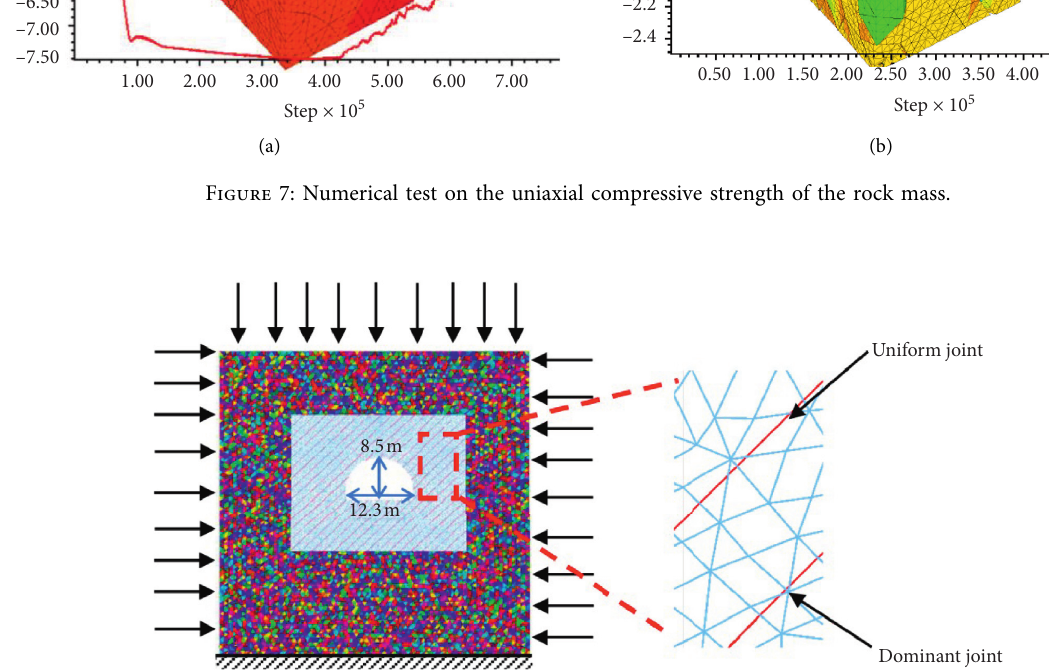
Figure 8: Numerical computation